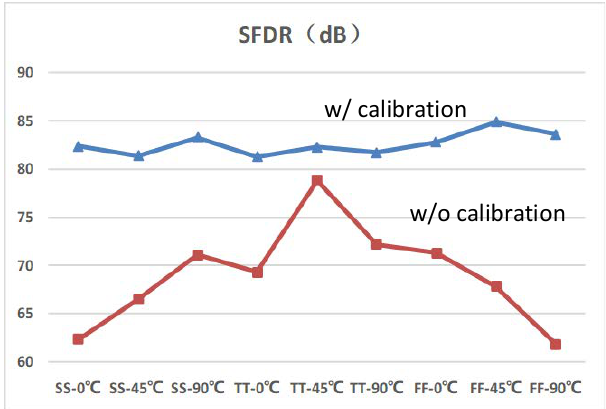
Figure 6. Simulation results of spurious-free-dynamic-range (SFDR) at different corners.